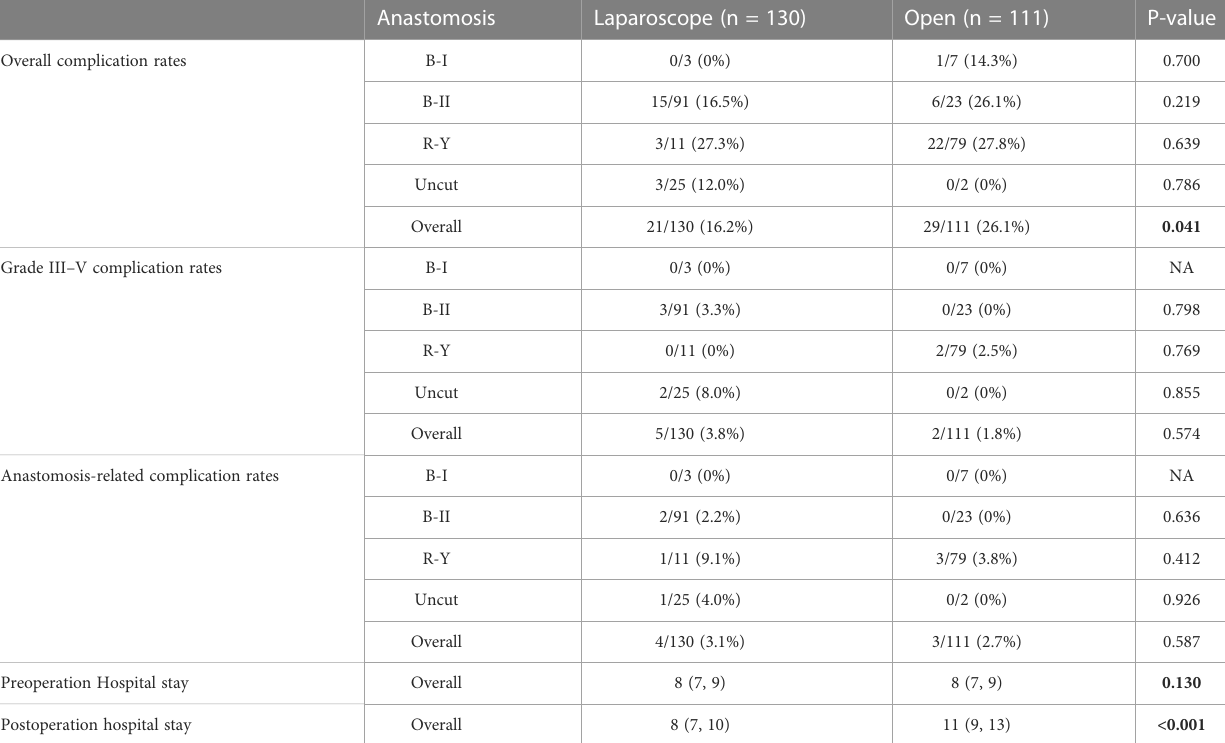
TABLE 4 The overall information of complication rates and hospital stays of all enrolled POO cases between open and laparoscopic groups from